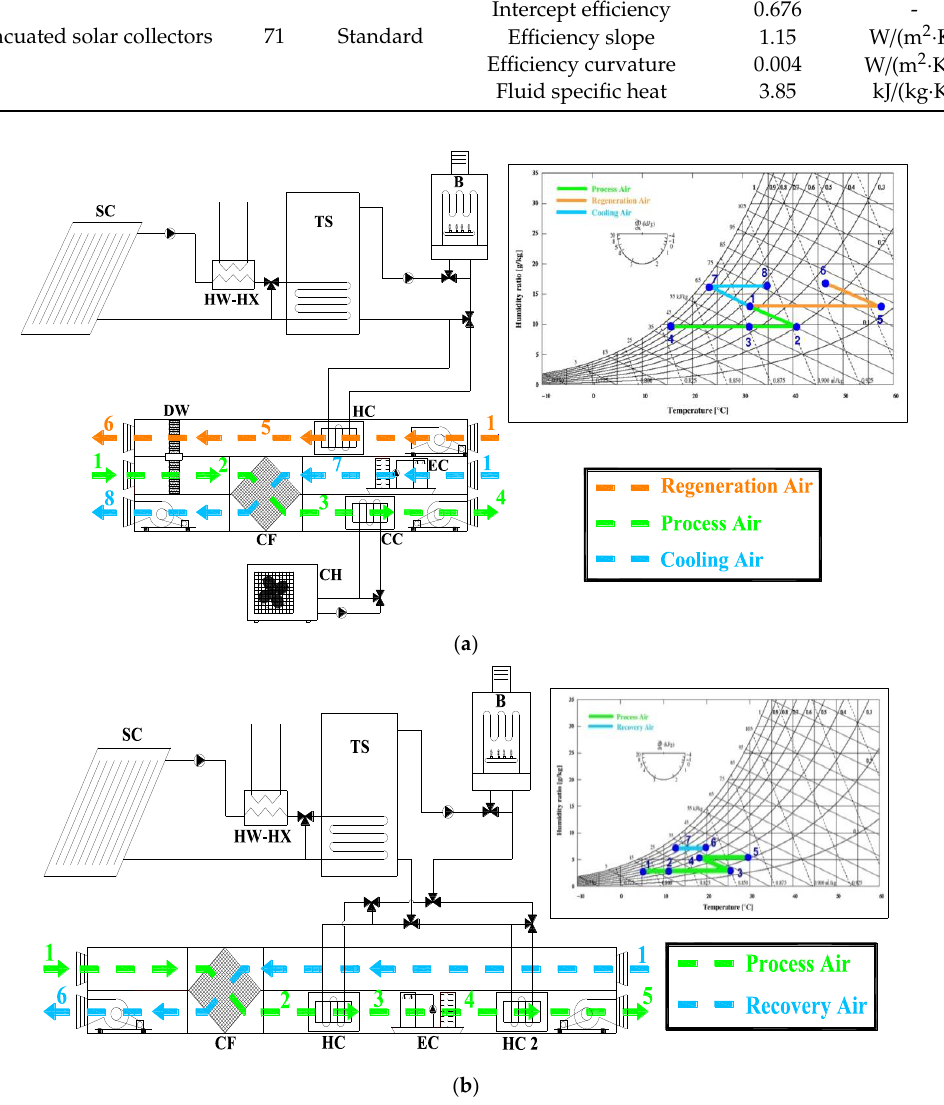
Figure 1. Alternative system layout in cooling mode ( a ) and heating mode ( b ).